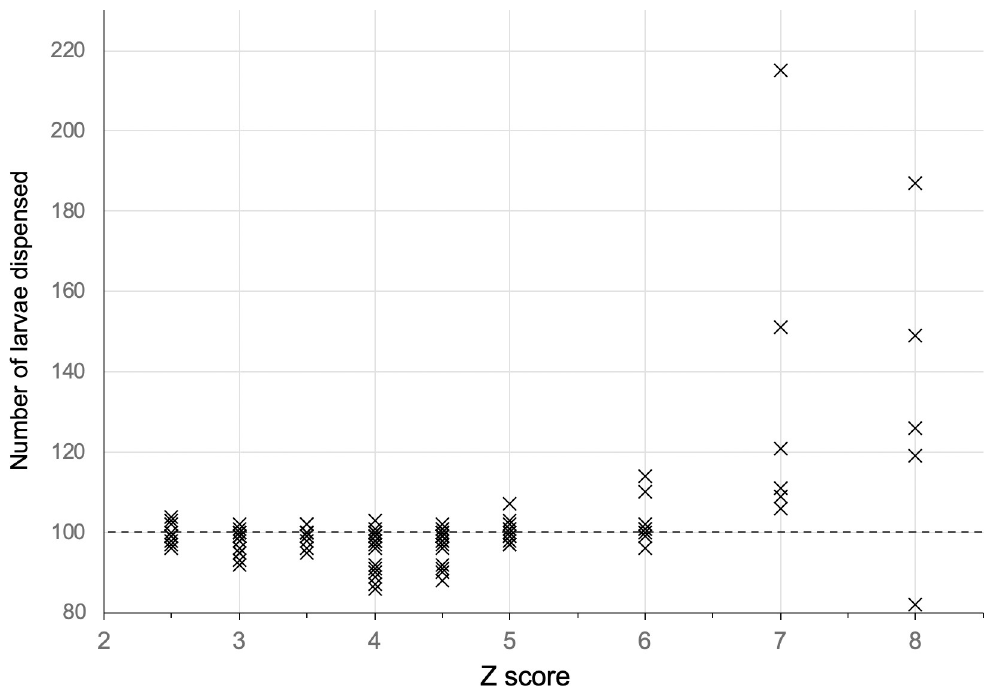
Fig 2. Z score effect. When using the ‘Smoothed Z-Score’ algorithm, a Z score sufficiently high to not detect e.g. food particles, eggshells and electronic noise must be selected to ensure that only larvae are counted. However, if the score is > 6, several larvae are not counted resulting in an excessive number being dispensed. The target number was 100 for these runs, indicated by the horizontal dashed line.